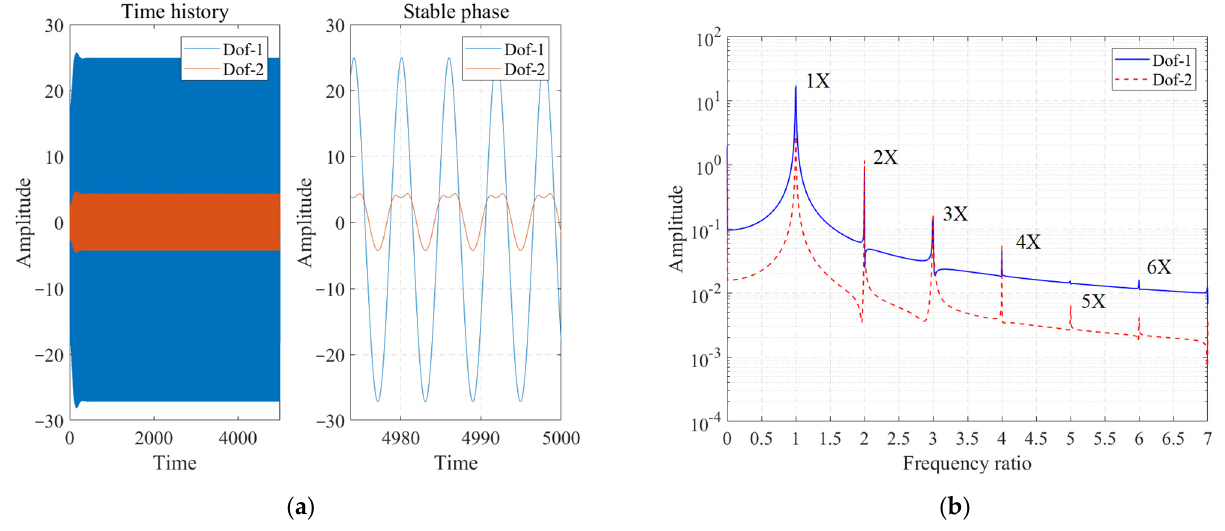
Figure 12. Time history and frequency spectrum of the system with an excitation frequency of 1.06 (Initial displacement is [3, 20], the initial velocity is [0, 0]): ( a ) time history; ( b ) frequency spectrum.